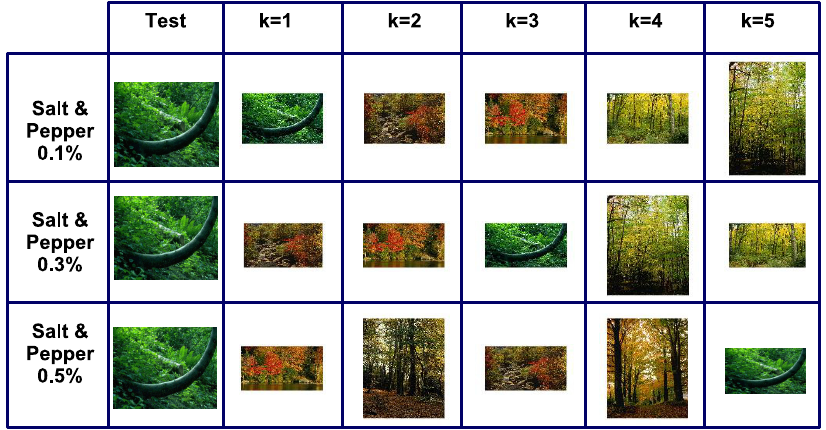
Figure 10. Test with images contaminated with salt and pepper noise at 0.1%, 0.3%, and